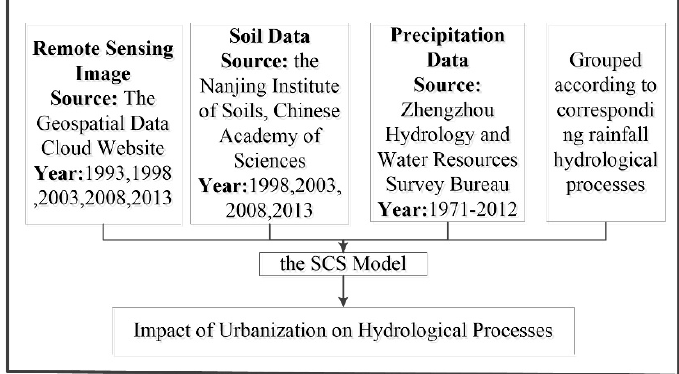
Figure 2. Flow chart of data and the applied methodology.